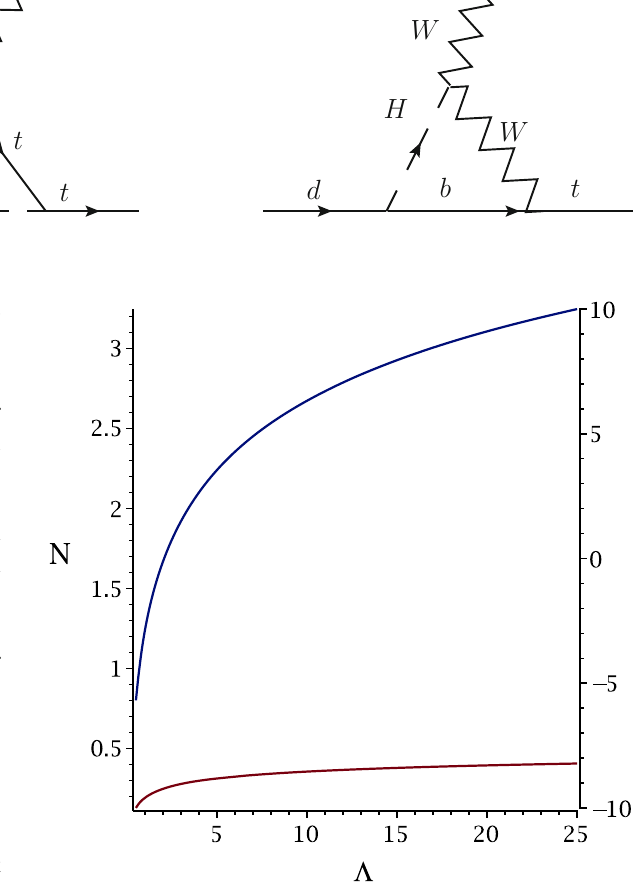
Fig. 8 The quantity N = N ((cid:2)) , in units 10 − 26 cm (at the vertical axis), as a function of cut-off (cid:2) in TeV (at the horisontal axis). The upper blue curve describes the bare case and the lower red curve the case with QCD corrections included